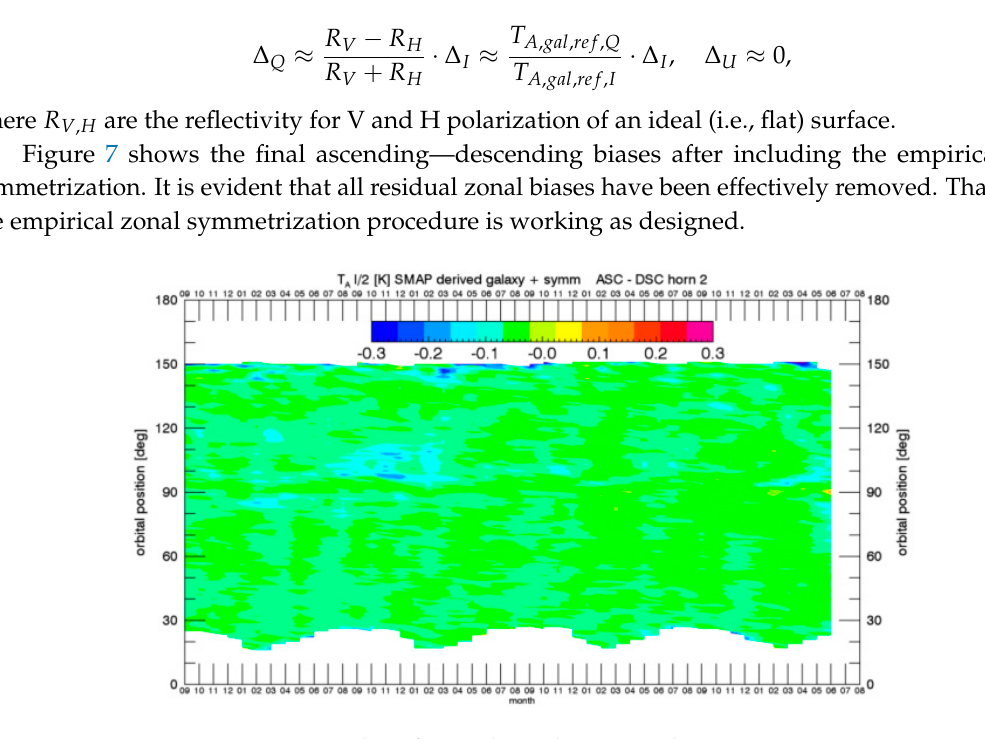
Figure 7. Same as Figure 5 but after applying the empirical symmetrization correction.